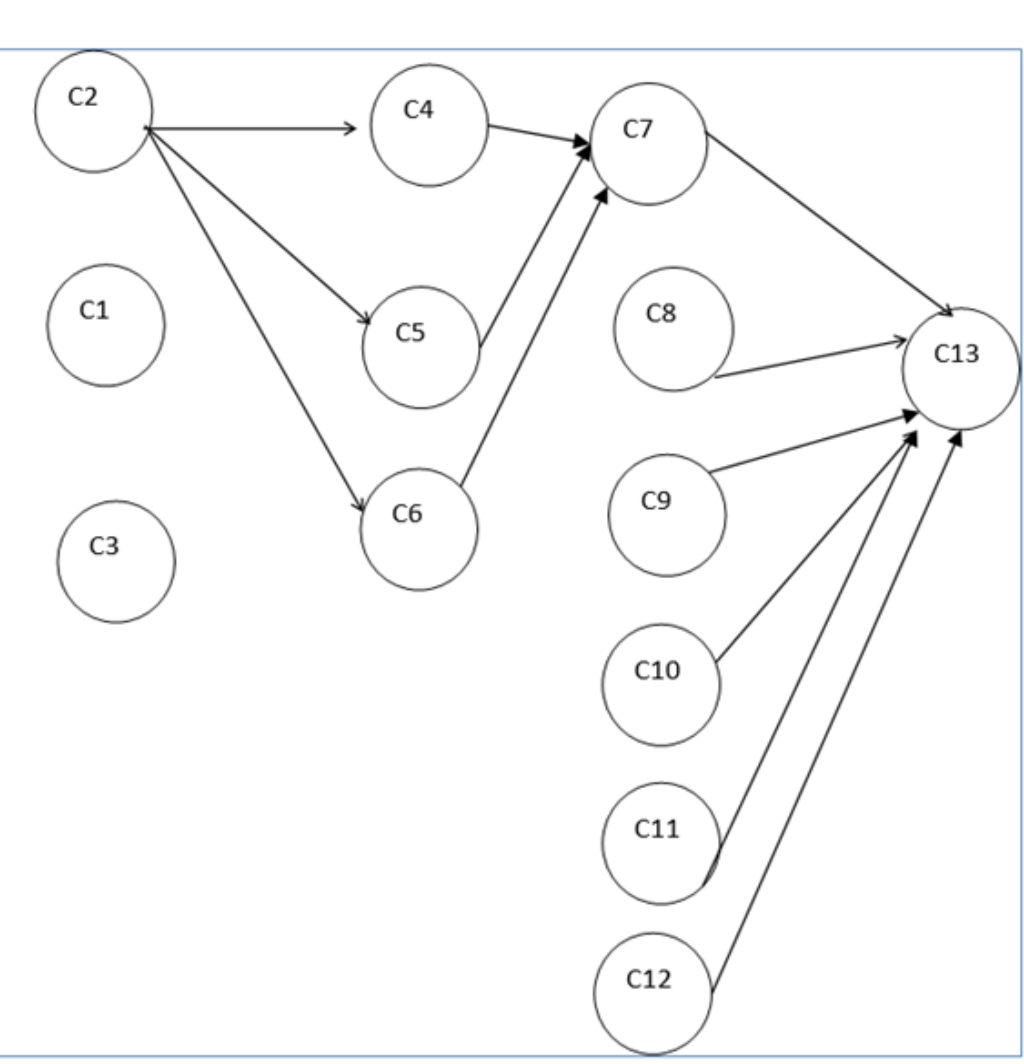
Fig. 5. Respective plithogenic sub cognitive